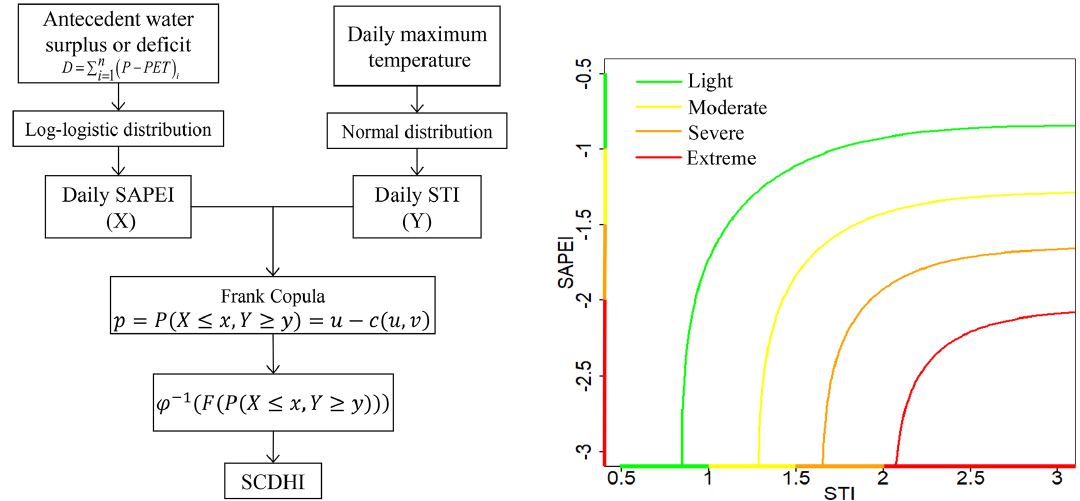
Figure 2. The graphical illustration of the SCDHI construction and the relation between the STI and SAPEI under different severity levels of compound drought and hot conditions (given by the legend). Different colors in abscissa and ordinate represent different drought or hot conditions (i.e., light, moderate, severe, and extreme). The isolines are calculated from a specific calendar day, using the fitted Frank copula with the parameter being − 1 . 31.